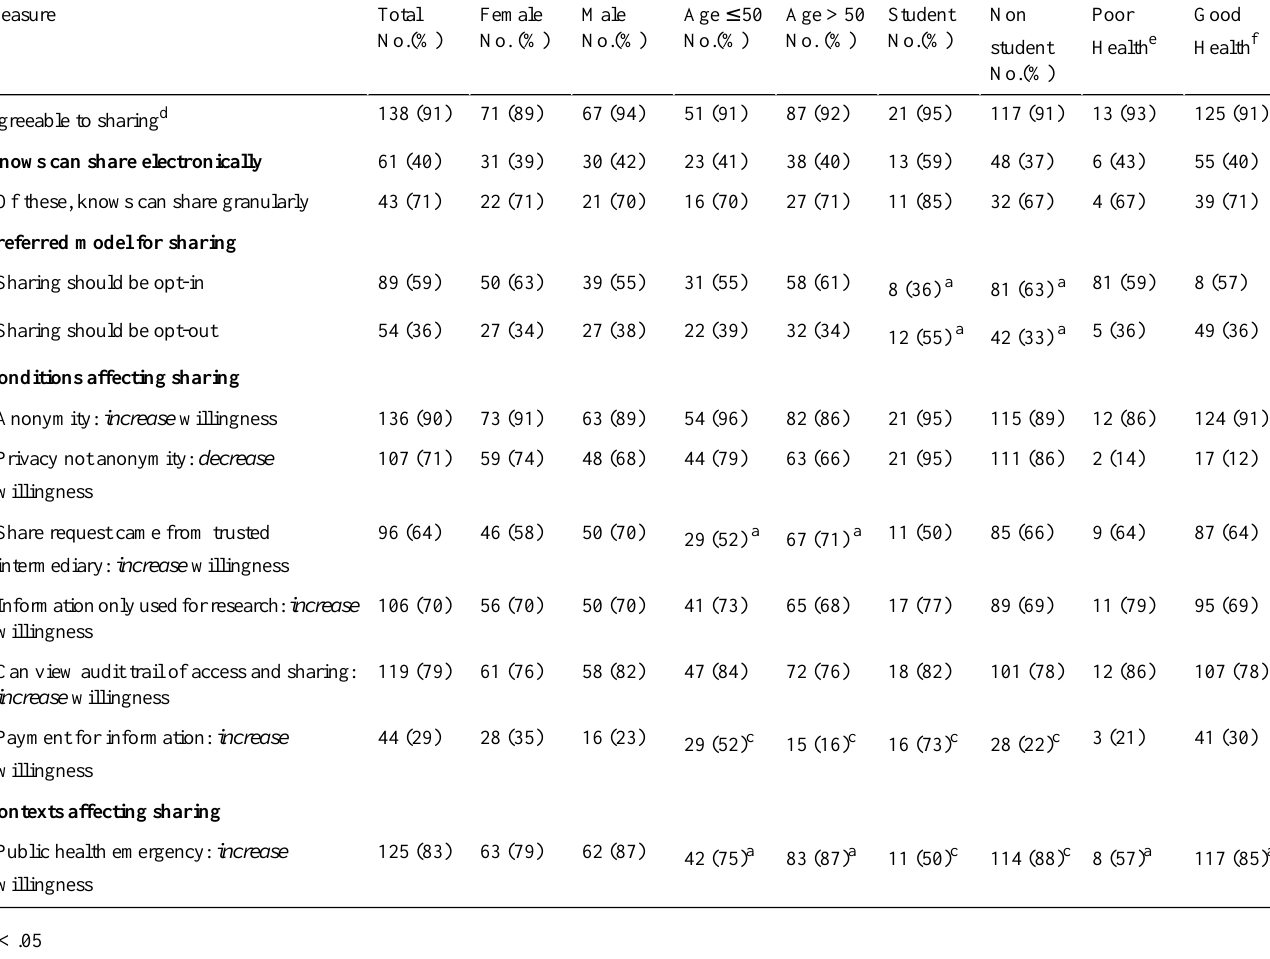
Table 2. Attitudes of demonstration evaluation subjects toward sharing PCHR data for public health research